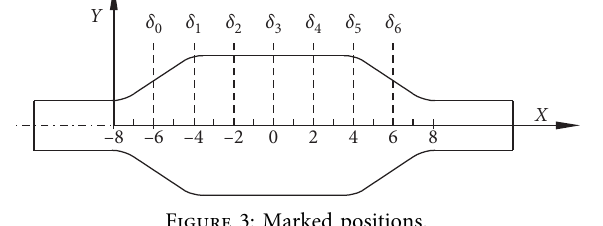
Table 1: Level table of orthogonal test factors.